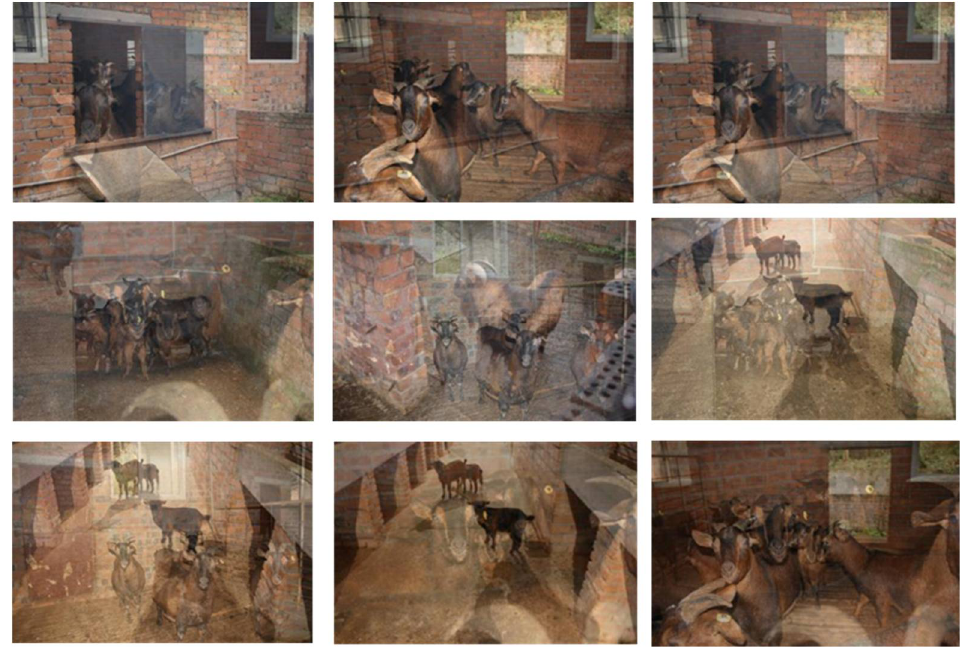
Figure 2. Images after Mixup augmentation processing.